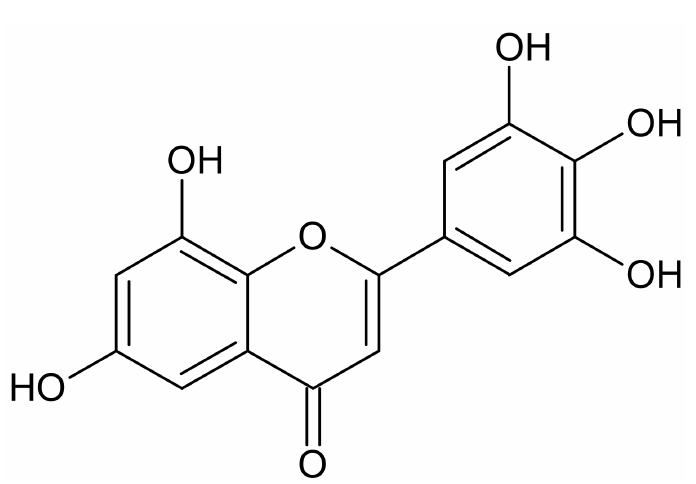
Figure 1. Structure of kaempferol.